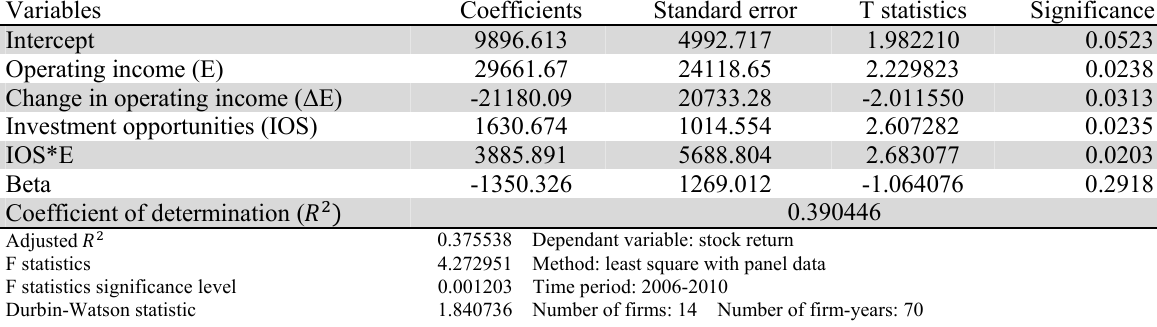
Model estimation results for firms with high life cycle score